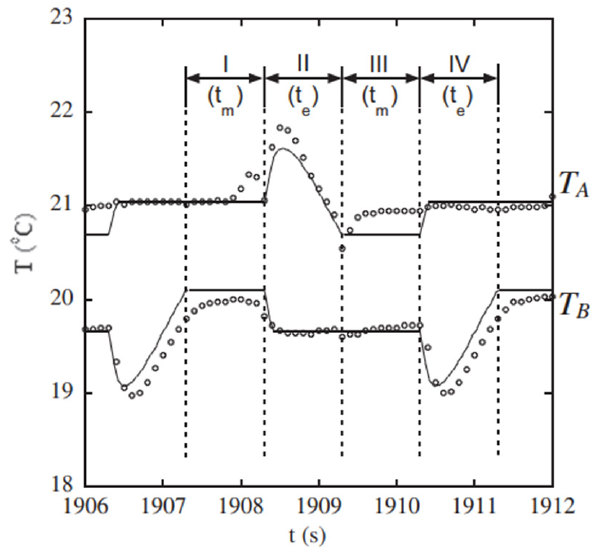
Figure 20. Comparison between the modeling results (solid line) and the measurements (dotted line) during the four phases of the AMRR cycle from step 1 to 4, respectively: magnetization, hot blow, demagnetization, and cold blow [98].